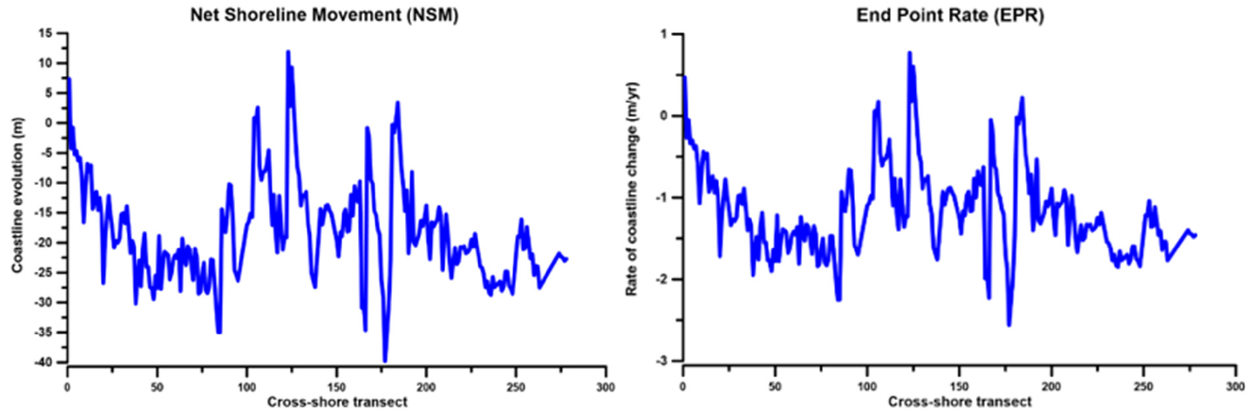
Figure 10. Evolution of the coastline between 2004 and 2019, showing the net shoreline movement (NSM) and the end point rate (EPR) ( left and right panels, respectively).